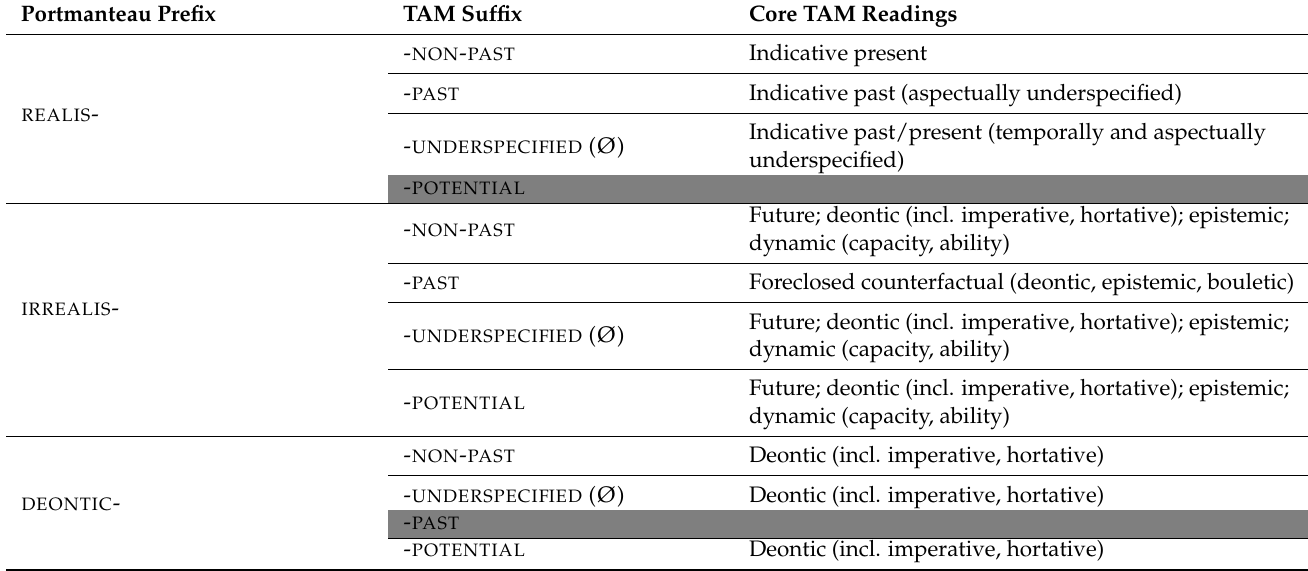
Table 2. Combinations of prenominal prefix and TAM suffix paradigms (positive polarity).